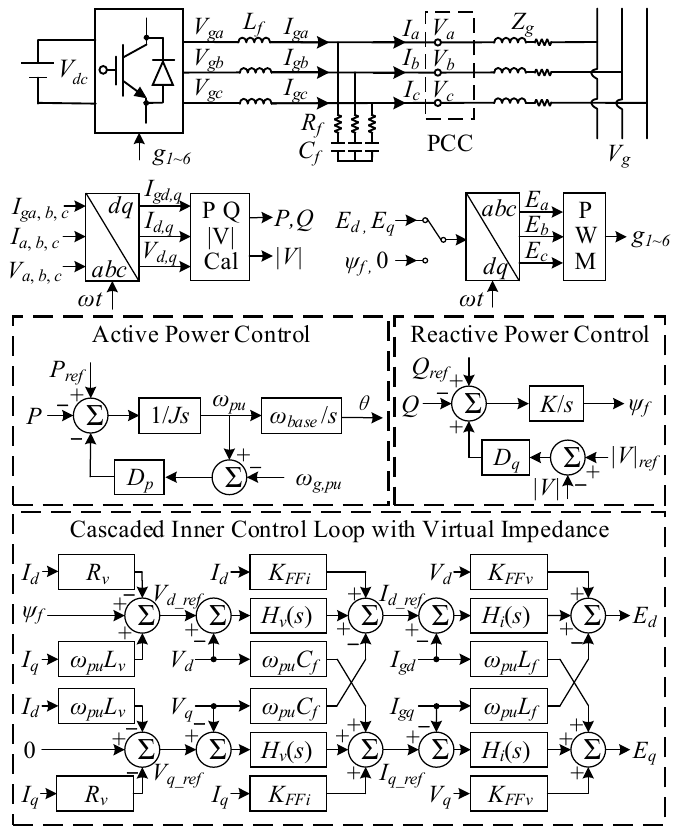
Figure 1. Configuration of VSG controlled converter system.